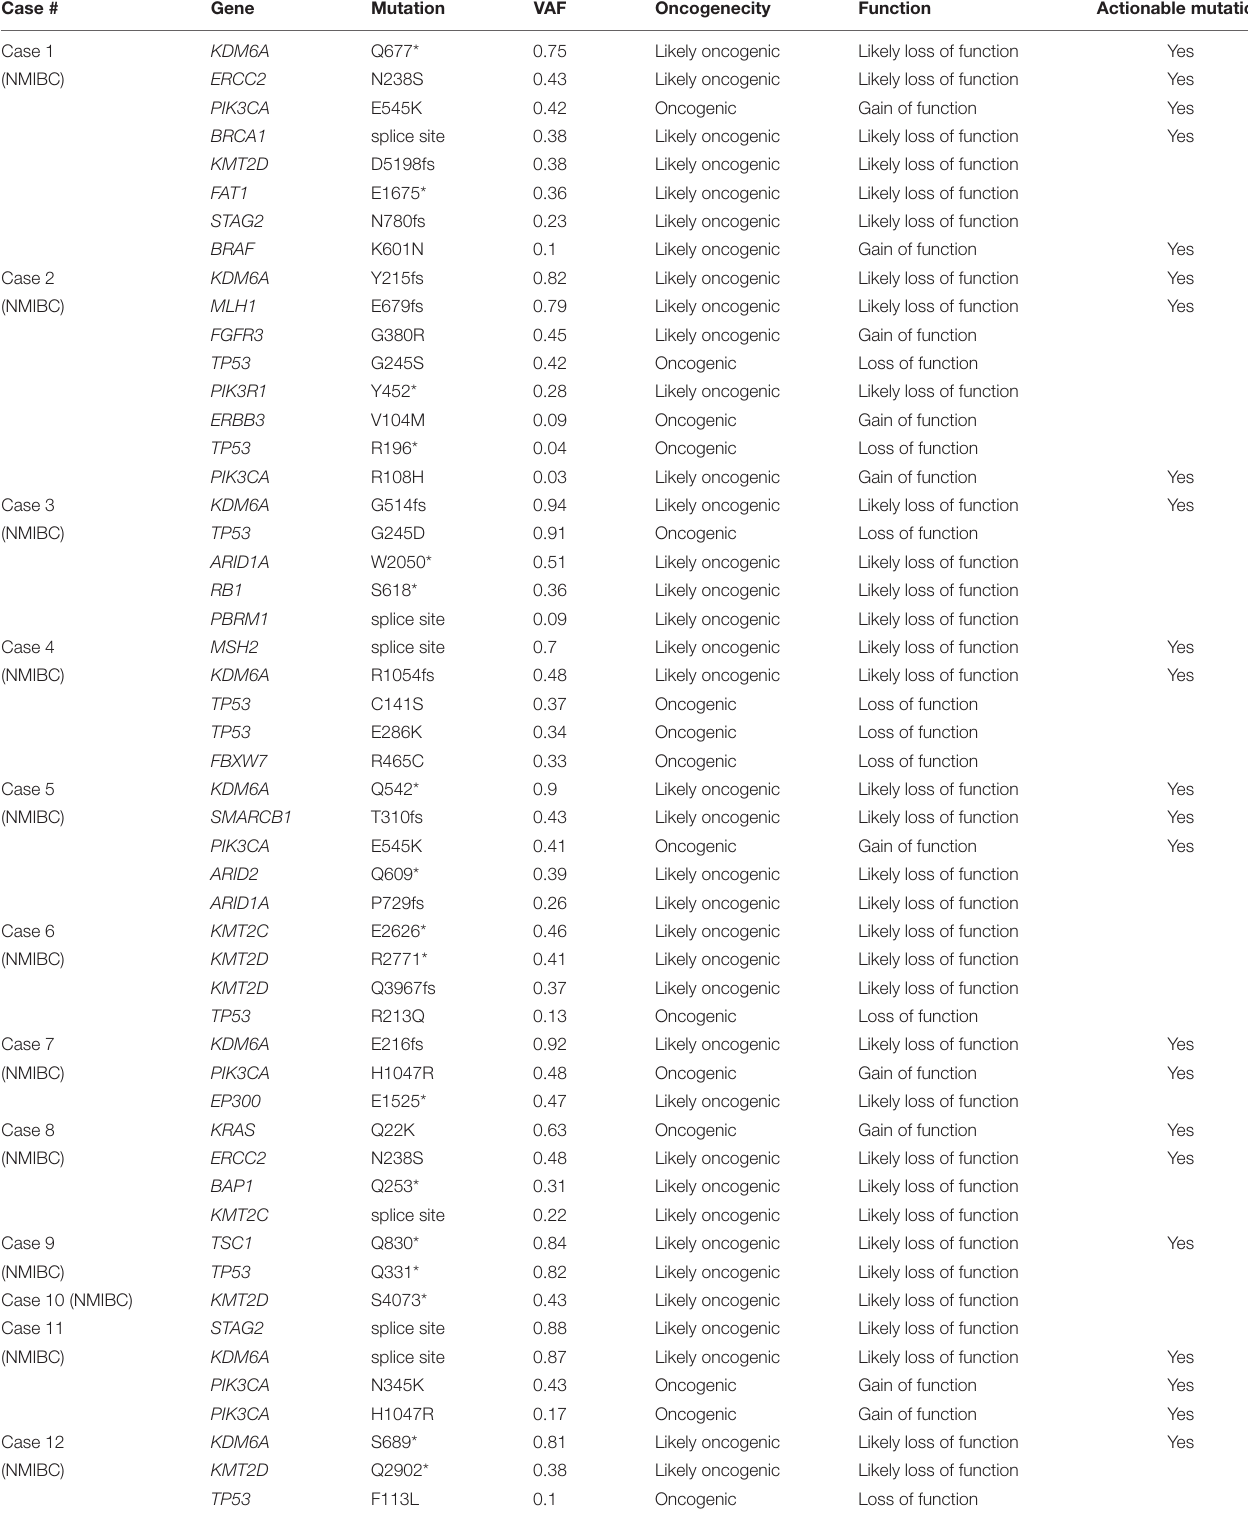
TABLE 1 | Oncogenic and actionable